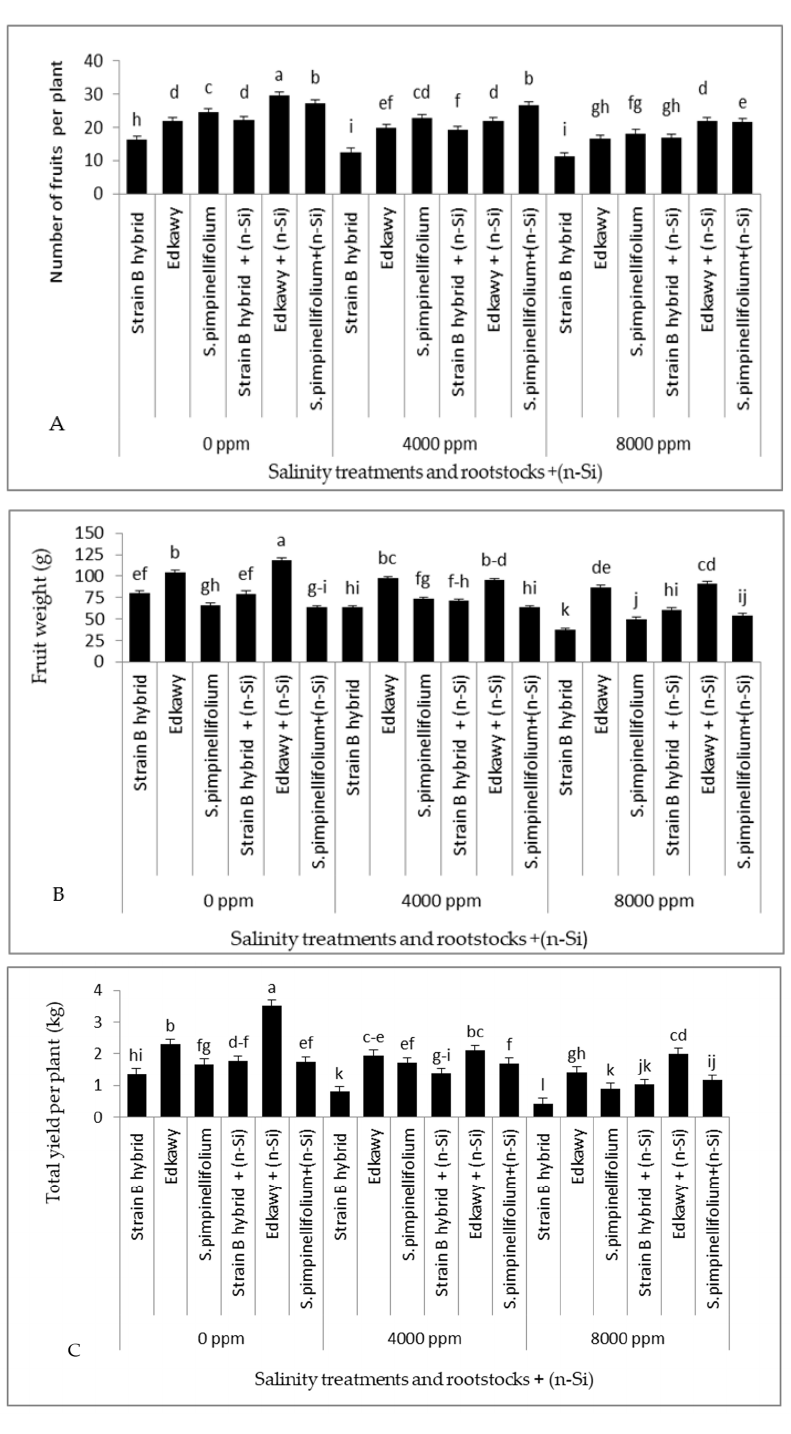
Figure 2. Effects of water salinity levels × rootstocks and foliar spray with (n-Si) interaction on ( A ) average number of fruits, ( B ) average fruit weight (g), and ( C ) average total yield per plant (kg). Vertical bars represent standard errors of the mean; in each bar, values followed by different letters differ significantly at p = 0.05 according to the LSD